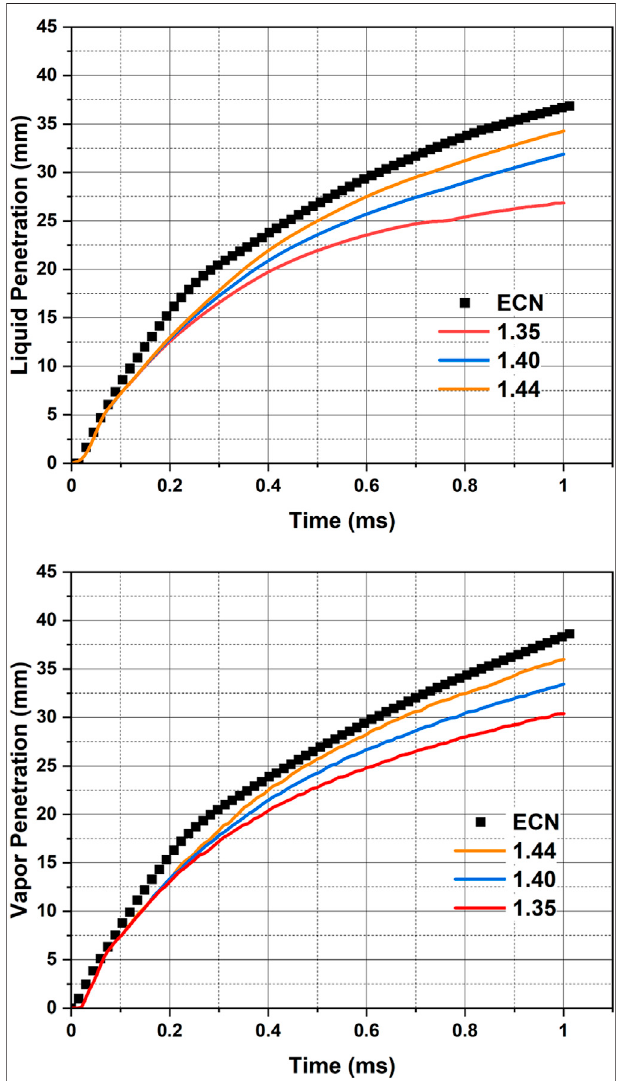
FIGURE 4 | Comparison of model predictions of liquid and vapor penetrations with the latest data measured by Sandia National Laboratories, available on ECN (ECN, 2022b) (Standard k – ε turbulence model used with C